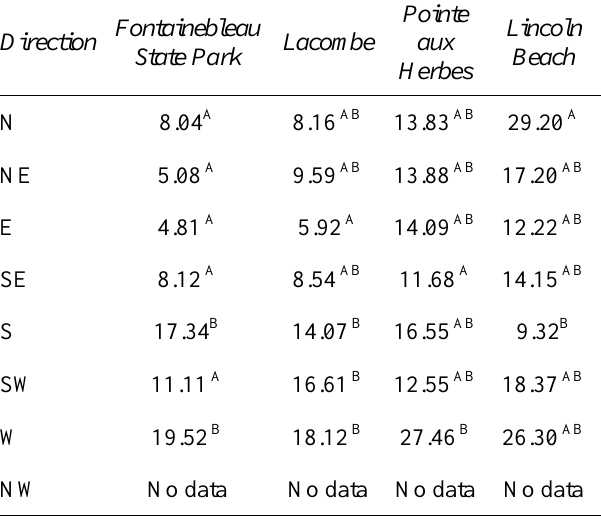
Table 3 : Mean turbidity values (NTU) for different wind directions at four turbidity-PAR monitoring sites. Data on resultant wind direction were obtained from Southern Regional Climate Center. Turbidity was compared using one-way ANOVA for each study site with wind direction as a fixed variable. The difference between values with the same superscript letter(s) is not statistically significant